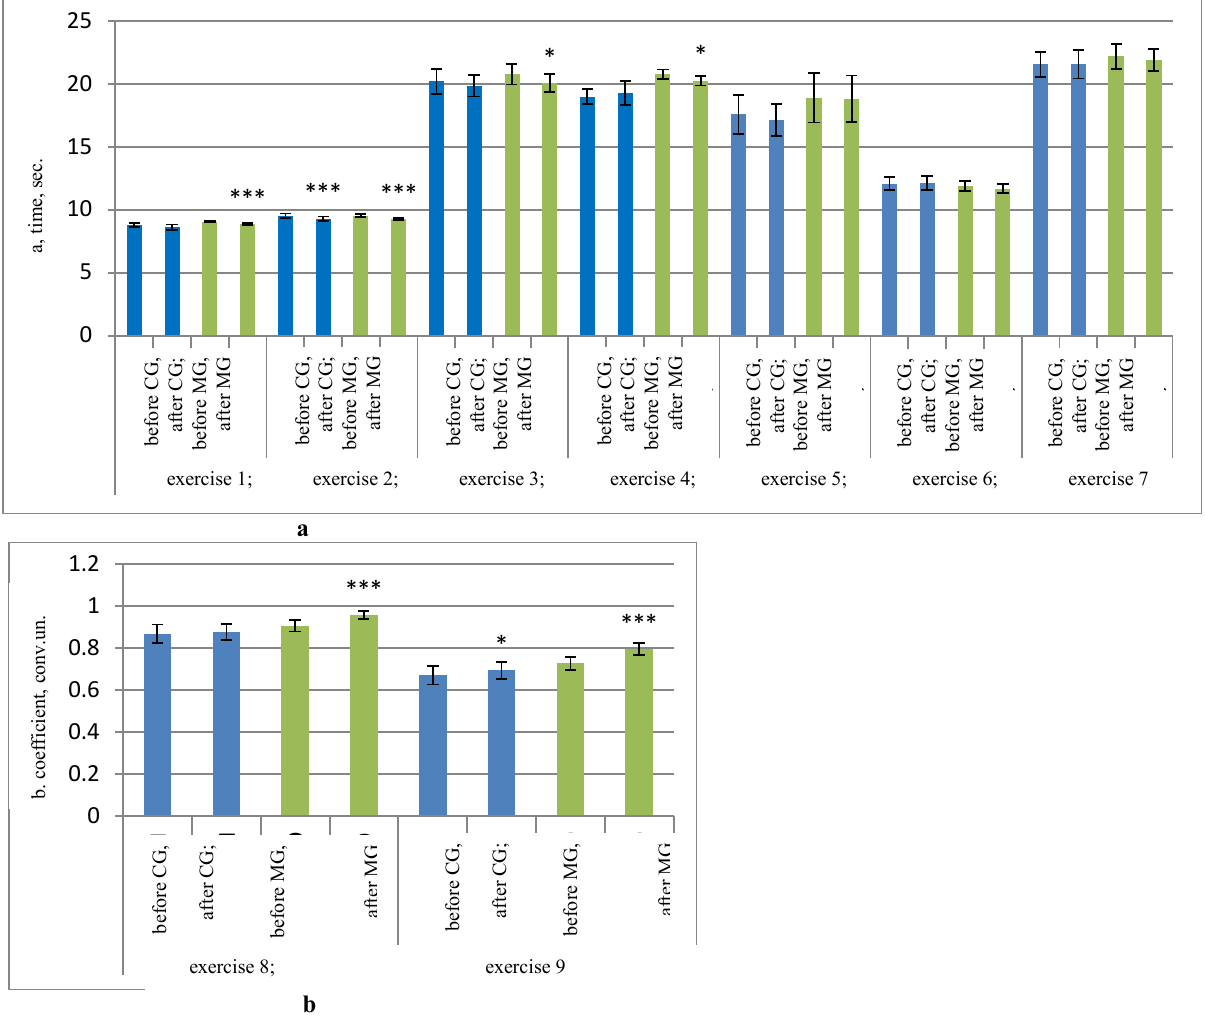
Fig.11. Indicators of control testing before and after experiment in main group (MG) and comparative group (CG), cluster “a-lactate”: a) a-lactate orientation; b) “lactate” orientation. (р ≤0.001). CG – comparative group; MG – main